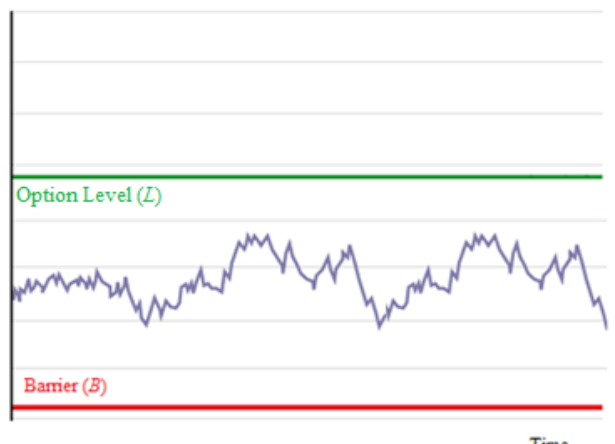
Figure 1. Underlying asset between the barrier and the option level.